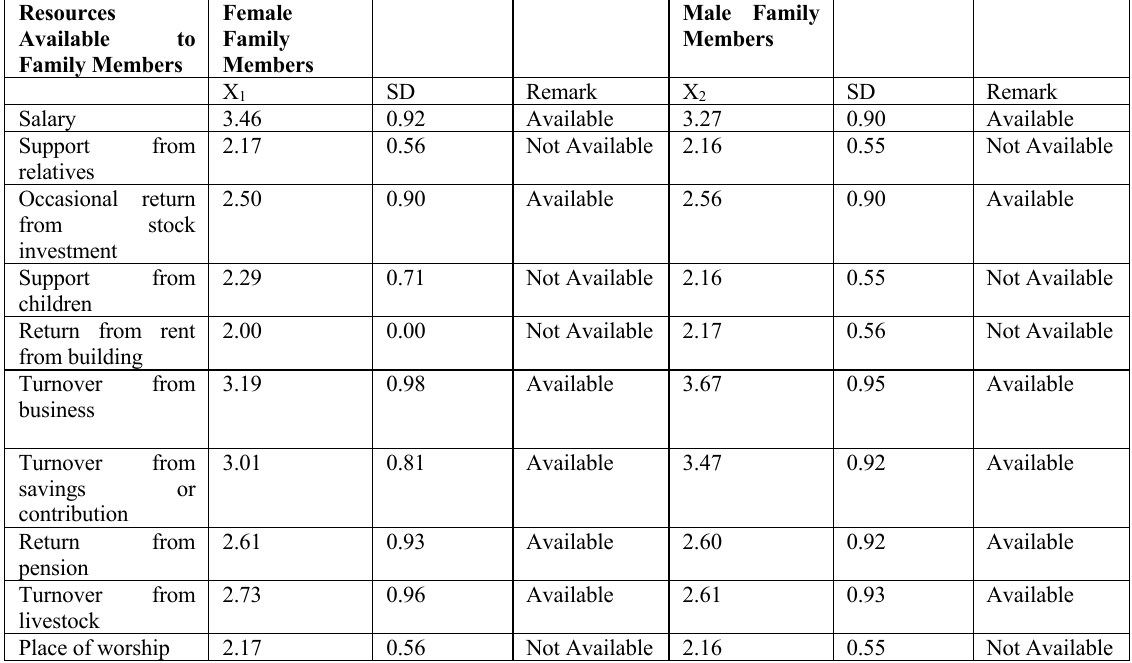
Table 1: Mean Responses on Sources of Income Available to the Families in Economic